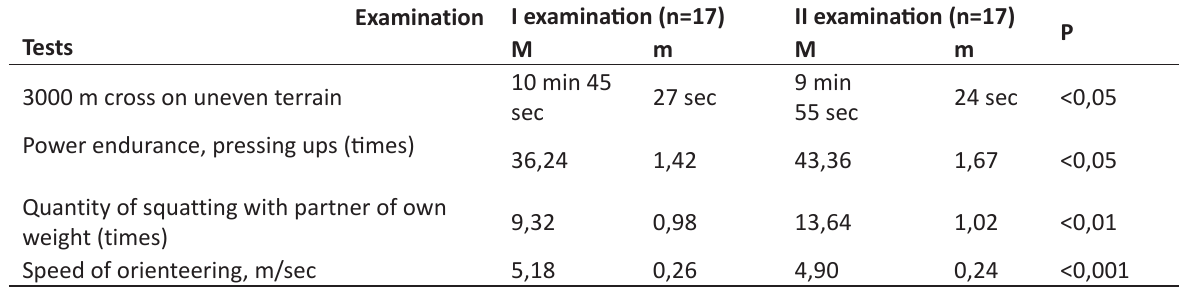
Table 1. Physical fitness of